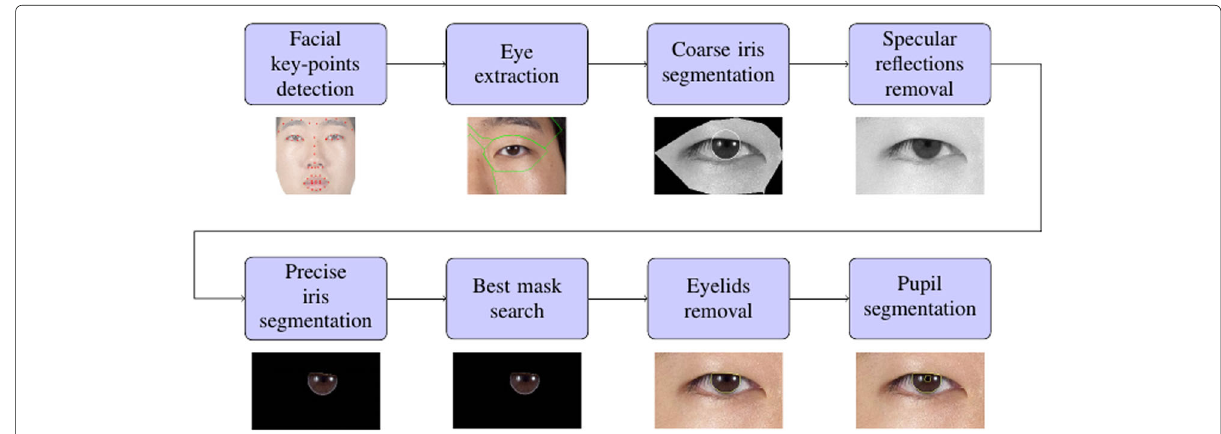
Fig. 1 Block diagram of the proposed